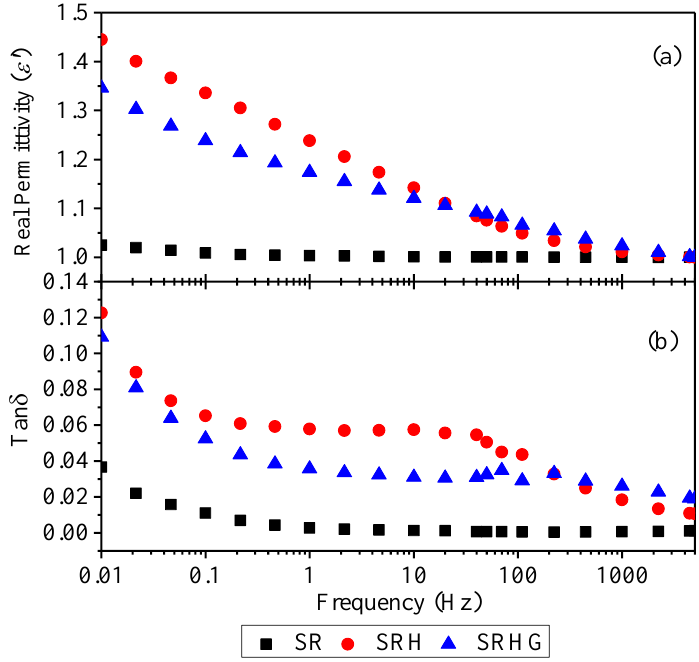
Figure 5. Dielectric response of samples ( a ) real permittivity and ( b ) dielectric loss tangent.